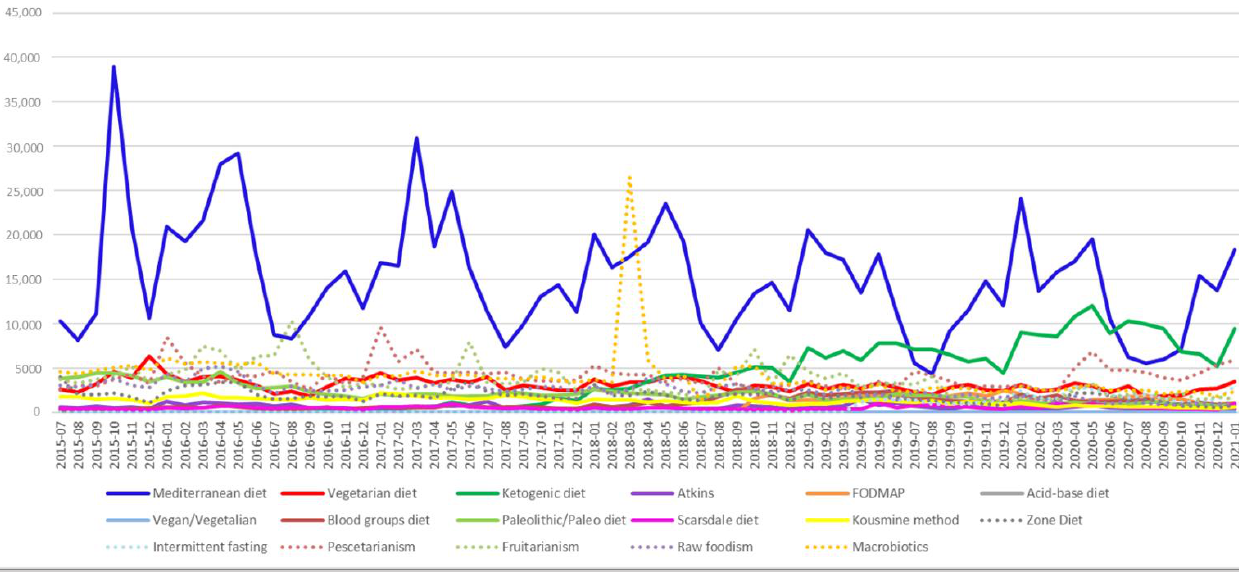
Figure 1. Percentages of the number of times a specific page was viewed by users out of the total number of times all pages were consulted. Table 1. Seasonal distribution and differences in the number of times a specific page was viewed by users.